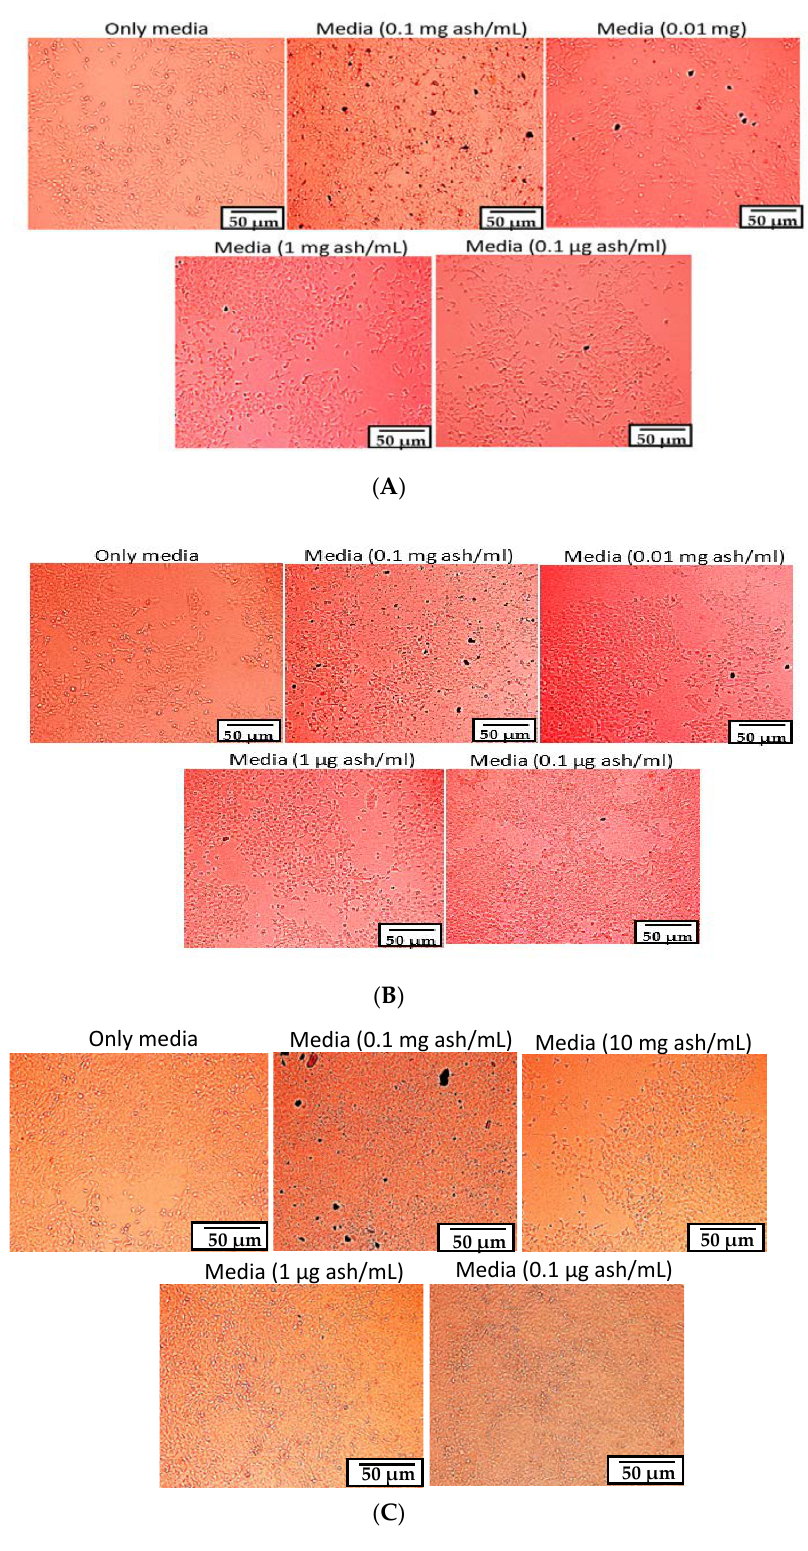
Figure 4. Representative images of cell viability on MCF-7 cells after ( A ) 24 ( B ) 48 and ( C ) 72 h of treatments with different concentrations of GBA. Scale bar denotes 50 µm.